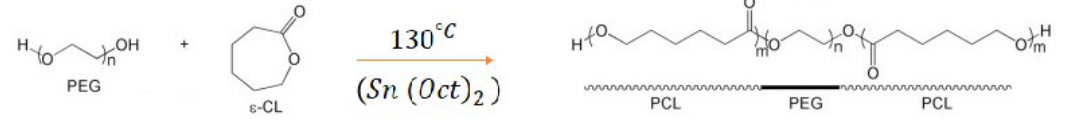
Fig. 2: Scheme of the synthesis of the PCL-PEG-PCL